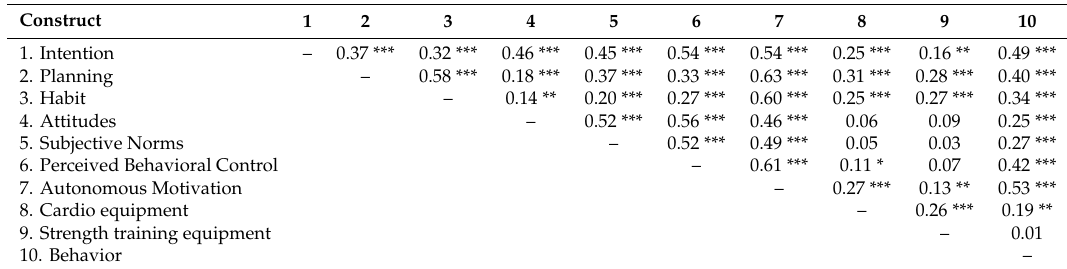
Table 3. Zero-order correlations among study